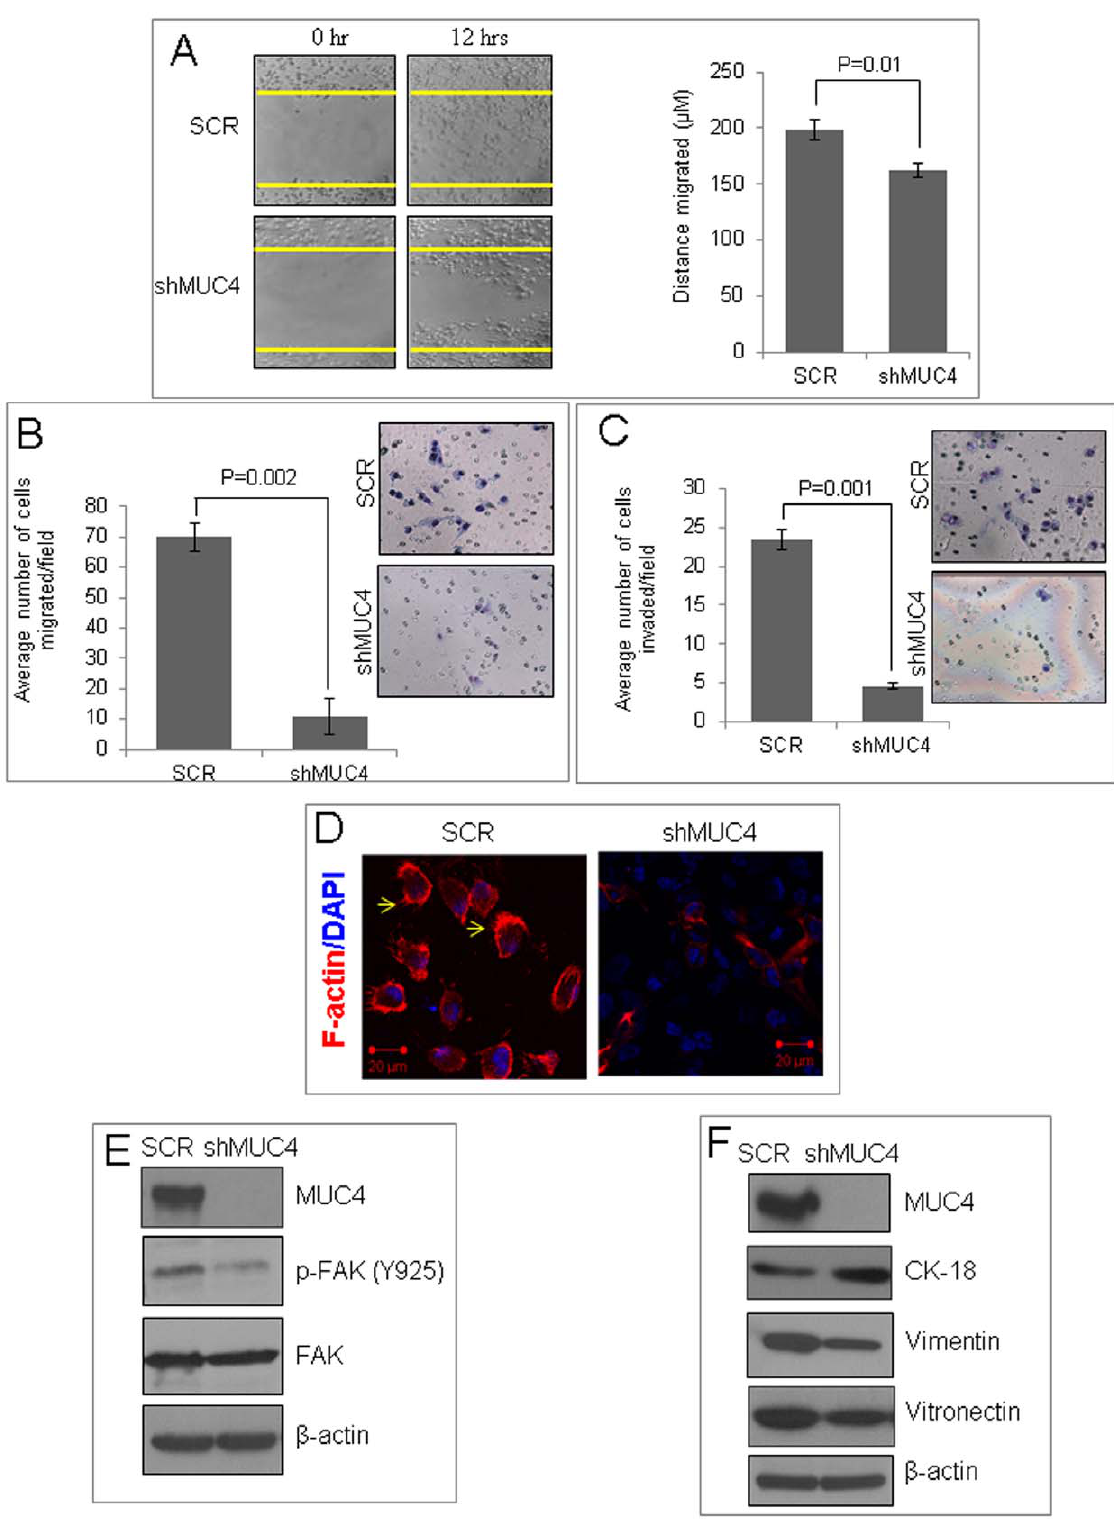
Figure 3. MUC4 enhances migratory and invasive potential. ( A ) After 24 hours serum starvation, a wound was created with a plastic tip on plates containing control or MUC4 knockdown cells. Cells were incubated in complete media for 12 hours. Motility of cells was photographed under bright-field microscopy (left, 10 6 magnification). After 12 hours, the migration of control cells and MUC4 knockdown cells was measured (in m m 2 ) using DatInf Measure setup wizard software (http://tucows.texasonline.net). Values were calculated and plotted (right). ( B and C ) Control and MUC4 knockdown cells were serum starved for 48 h and seeded on non-coated or Matrigel-coated membranes for motility ( B ) and invasion ( C ) assays, respectively, and incubated for 24 h. Medium containing 10% fetal bovine serum in the lower chamber was used as a chemo-attractant. Cells that did